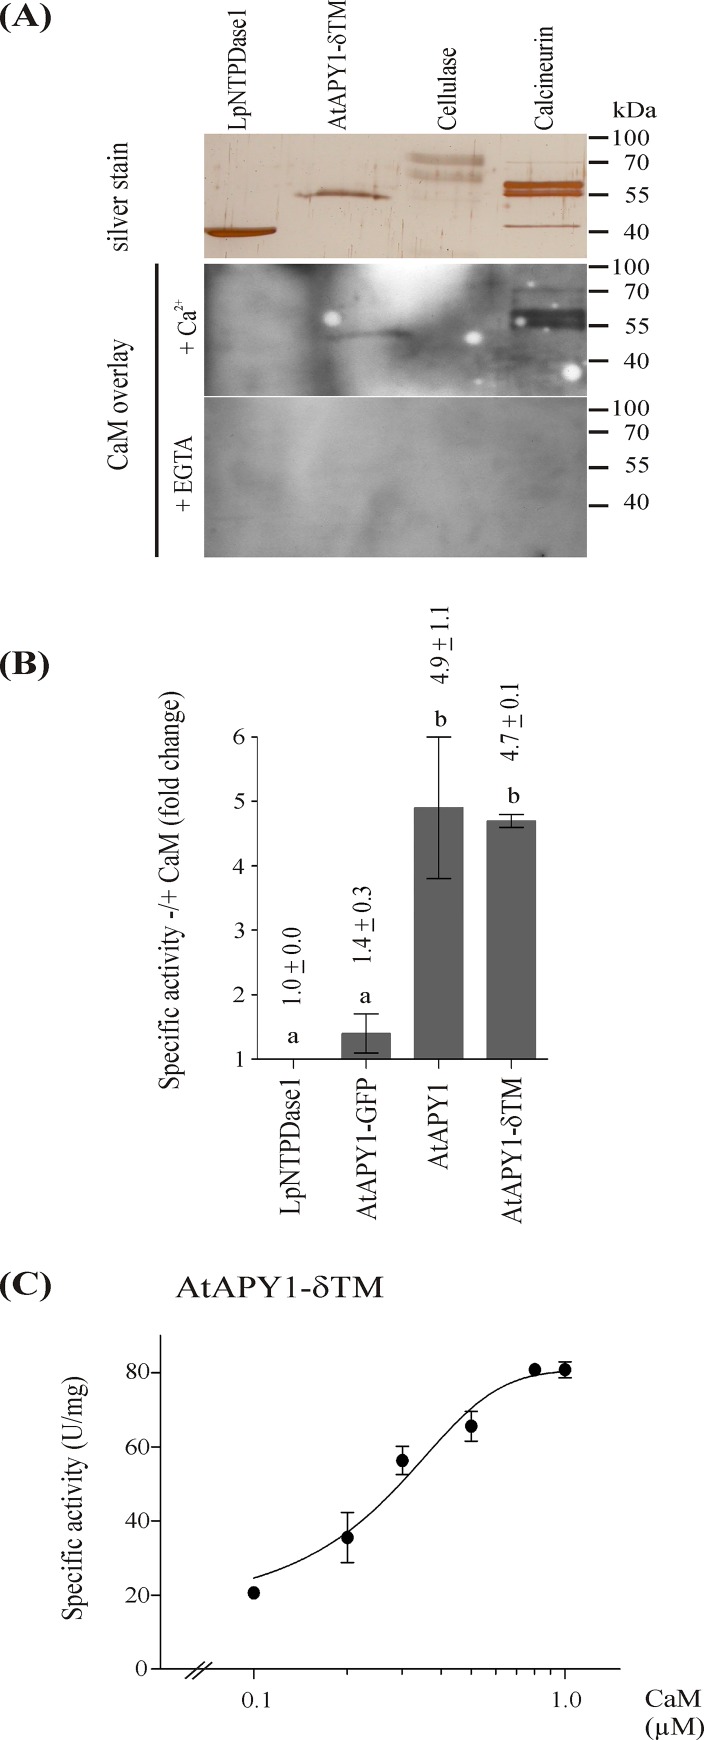
Stimulation of AtAPY1 activity by CaM.(A) Similar amounts (~ 150 ng) of the specified proteins were loaded per lane of a 12% SDS gel, separated by PAGE and subsequently either silver-stained or blotted onto a membrane for a CaM overlay in the presence of either calcium or EGTA. For each of the three applications, all samples were processed in parallel and identical volumes of the same protein sample were loaded. Biotinylated CaM bound by the proteins was detected via chemiluminescence after incubation with alkaline phosphatase coupled to streptavidin. The exposure time for the detection of CaM binding on the Ca2+-treated membrane was 1 s versus 60 s for the EGTA-treated membrane based on normalization via a positive control shown in S10 Fig. The results are representative of three independent CaM overlays. (B) The specific activities were determined by the discontinuous assay in the presence of 1 mM CaCl2 and 3 mM ADP (LpNTPDase1) or 3 mM UDP (AtAPY1-GFP, AtAPY1, AtAPY1-δTM) and compared with the activities under the same conditions, except for the addition of 0.8 μM CaM (LpNTPDase1) or 1.0 μM CaM (AtAPY1-GFP, AtAPY1, AtAPY1-δTM). Error bars represent the standard deviations of the means in fold activity change by the presence of CaM from two independent activity assays. (C) The specific activity of AtAPY1-δTM was determined by the discontinuous assay in the presence of 3 mM UDP, 1 mM CaCl2 and rising concentrations of CaM as indicated. The data were fit to the Hill equation. The means + SD of duplicates from one assay are shown. The result is representative of two independent assays. 1 U = 1 μmol Pi /min.